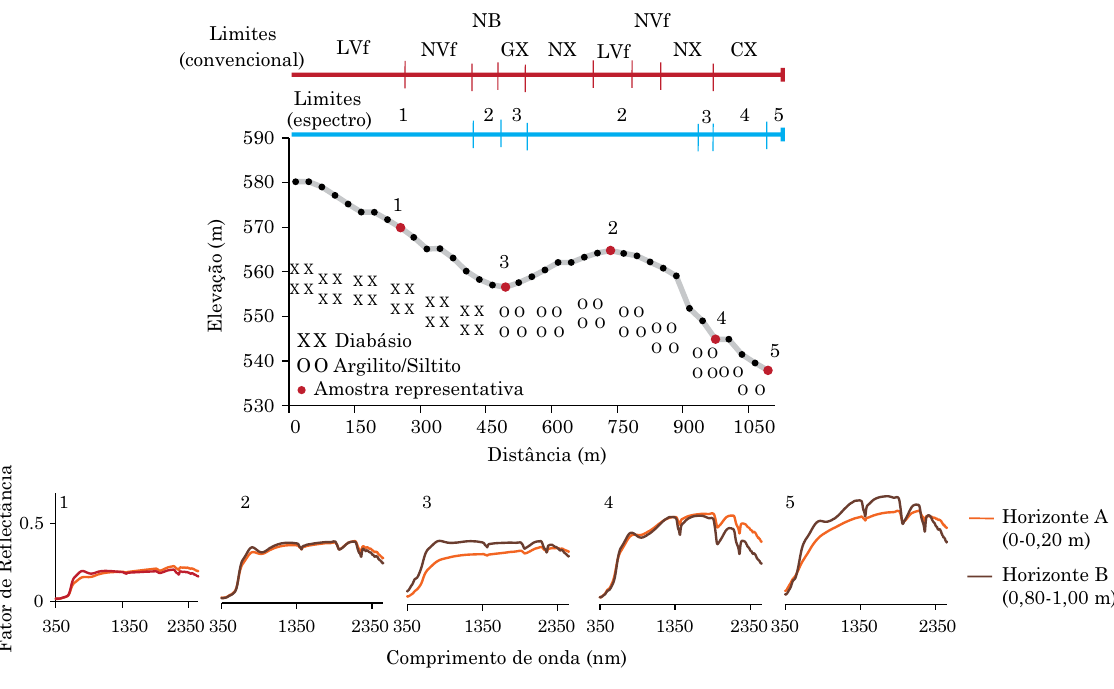
Figura 5. topossequência E e limites de classes de solos determinados por métodos convencional e espectral. os pontos 1, 2, e 3 correspondem às amostras representativas às suas unidades espectrais (pontos em vermelho), apresentando as curvas espectrais dos horizontes a e B.